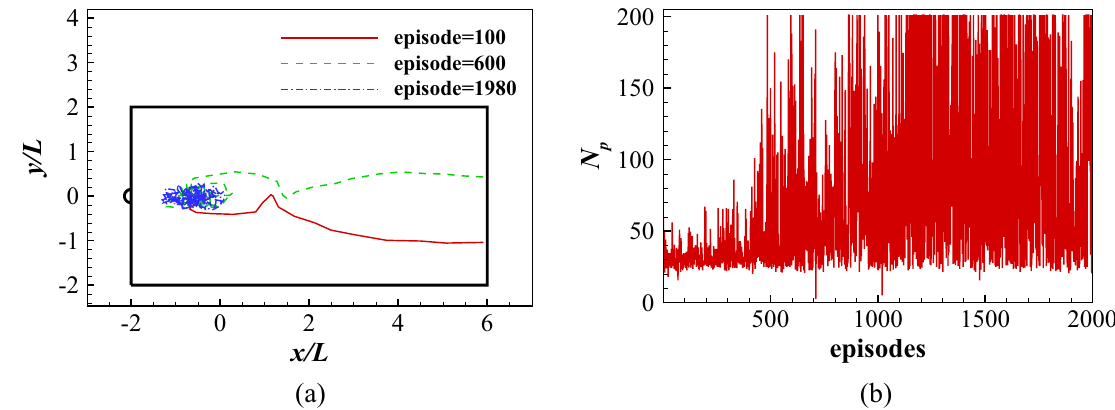
Figure 16. Position holding in a Kármán vortex street: ( a ) the traces of the head during different learning stages; and ( b ) the total number of periods the fish maintains in the swimming area for all episodes considered.